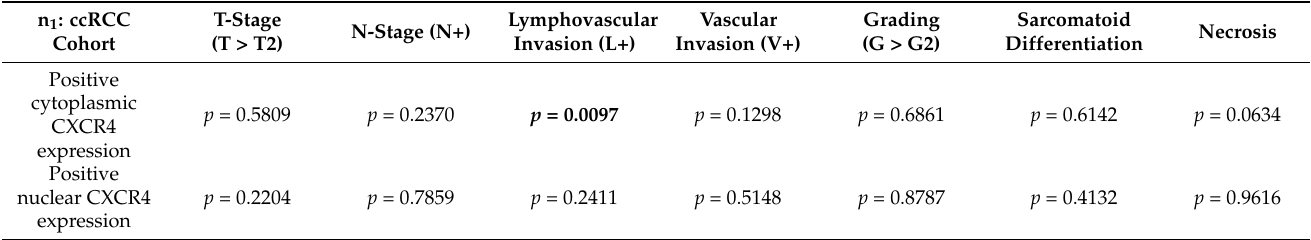
Table 4. Correlation of positive CXCR4 expression (cytoplasmic and nuclear) with clinicopathological parameters in cohort n 1 . Bold p -values are statistically significant.